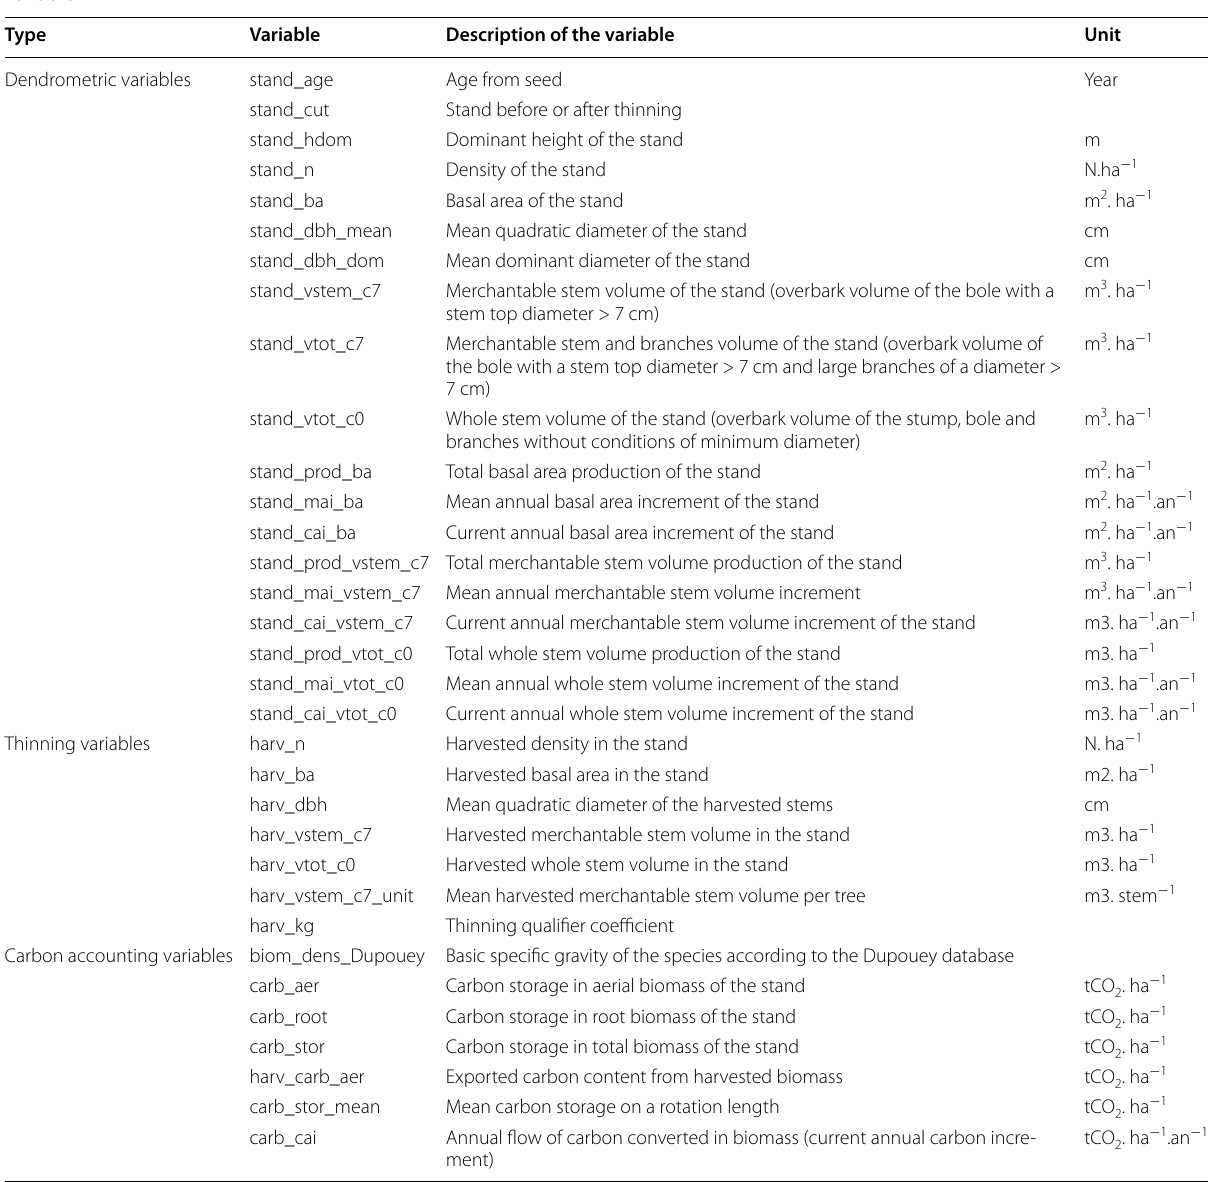
Table 2 Overview of the variables from the dendrometric, thinning and carbon segments of the database with the definition of the